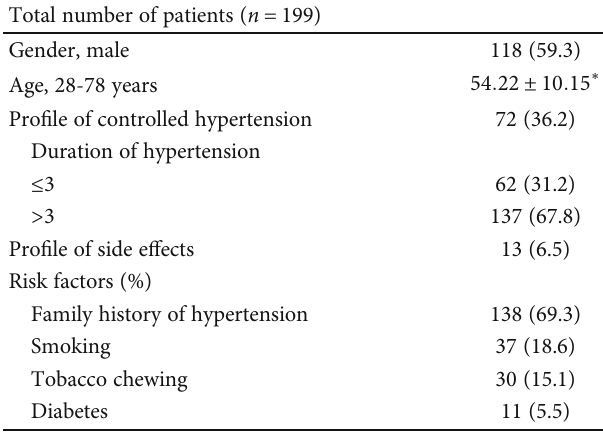
Table 1: Demographic characteristics of the analyzed population.